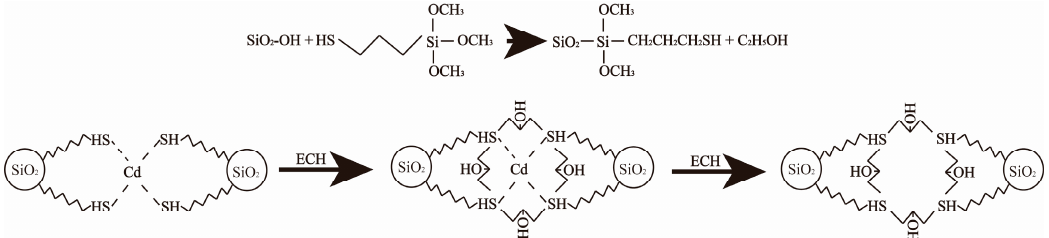
Figure 1. Preparation procedure of IB.